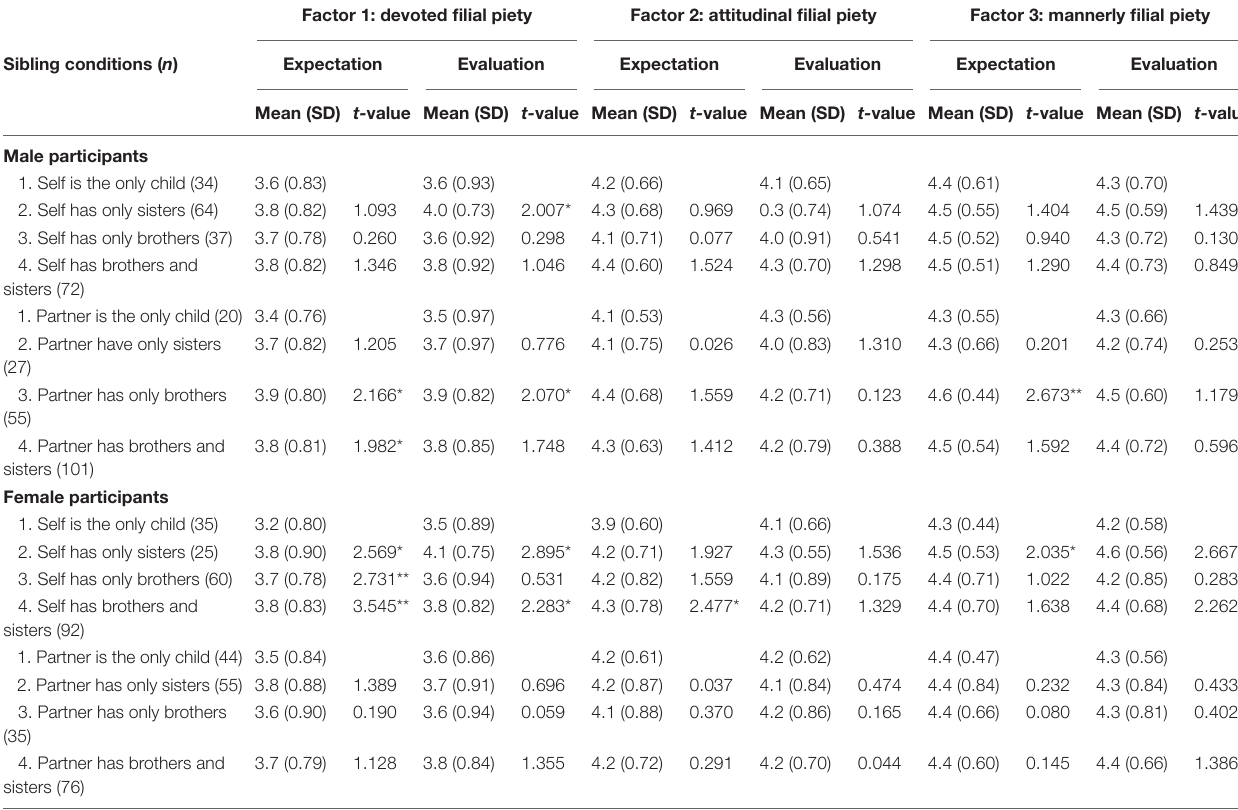
TABLE 3 | Independent t -test comparisons of expectation and evaluation of spouse’s filial piety between different sibling conditions. Factor 1: devoted filial piety Factor 2: attitudinal filial piety Factor 3: mannerly filial